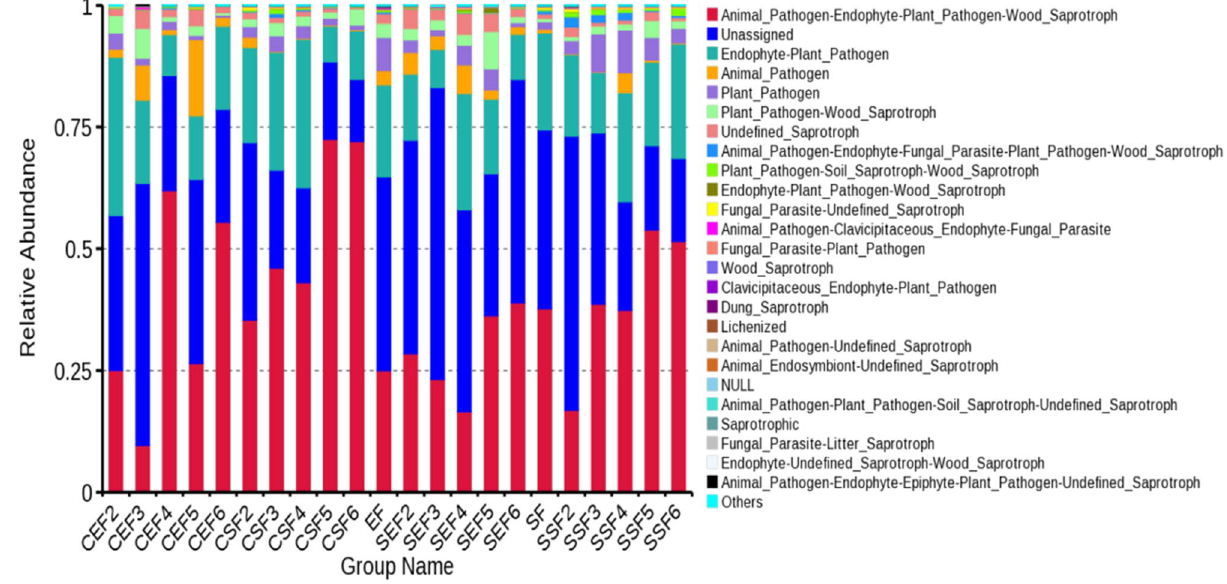
Figure 14. Relative abundances of function annotations of fungal communities in